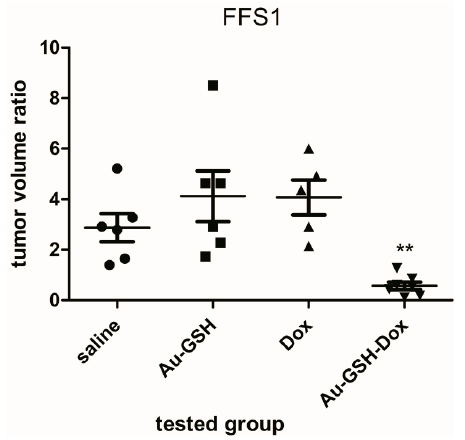
Figure 1. Volume ratio of tumours grown from the FFS1 cell line 72 h after a single intratumoural injection of the following compounds: saline (as a control) ( ● ), Au-GSH ( ■ ), Au-GSH-Dox ( ▼ ), Dox ( ▲ ) compared to the tumour volume before treatment. ** p < 0.01 was assigned as highly significant.